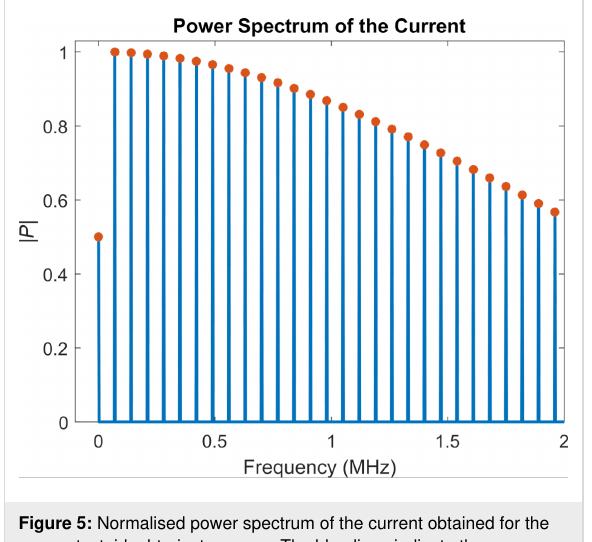
Figure 5: Normalised power spectrum of the current obtained for the noncontact, ideal-trajectory case. The blue lines indicate the power spectrum obtained via Fourier transform of the current, while the orange dots correspond to the predicted peaks from Equation 8. The first 50 elements of the infinite sum in Equation 8 were used for evalu- ating the equation. The results are in agreement with each other. Both the power spectrum and the predicted peaks are normalized. The figure also shows that the first harmonic (70 kHz), is the strongest peak in the spectrum, although the decay of the higher harmonic values is not rapid. Our calculations show that the peaks diminish to ca. 20% of the maximum peak value at a frequency of approximately 3.2 MHz, which roughly corresponds to the 46th harmonic.